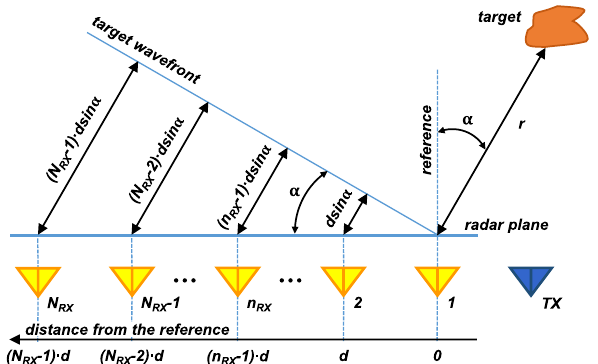
Figure 1. Uniform linear antenna array of a SIMO